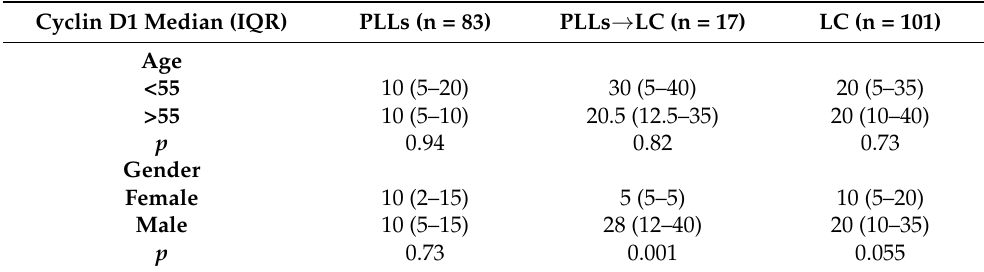
Figure 1. Immunohistochemical expression of Cyclin D1 in: ( a ) PLL—visible mostly in the nuclei of basal layer cells of hyperplastic epithelium (index: 32%, orig. magn. 200 × ); ( b ) LC: ( b1 ) in the GG homozygote patient—visible in single cancer cells (index: 5%, orig. magn. 200 × ); ( b2 ) in the AA homozygote patient visible as small cellular granules in nuclei of cells (index: 41%, orig. magn. 200 × ). Table 3. Expression of Cyclin D1 due to clinical, histological and epidemiological criteria in patients with laryngeal lesions (IA—impossible